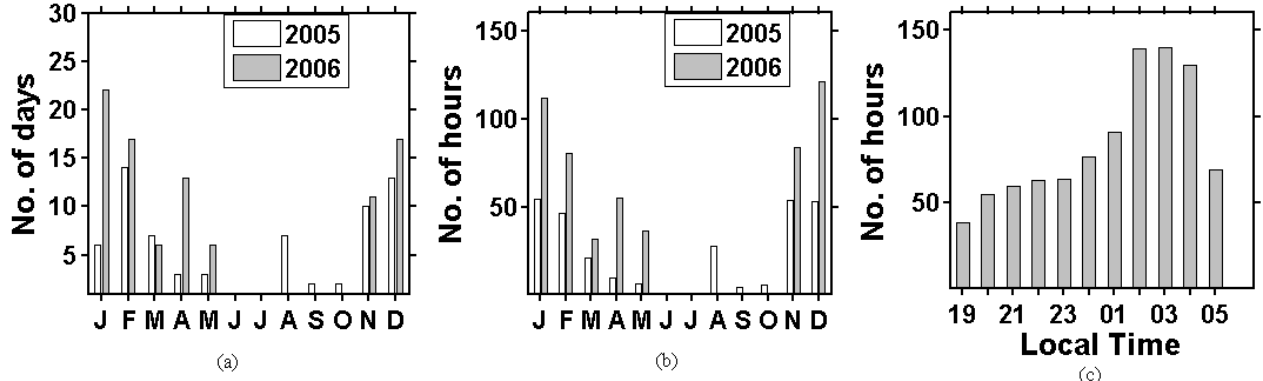
Fig. 1. Histograms showing monthly distribution of data for the period from January 2005 to December 2006 (a) number of days, (b) number of hours of sodium lidar data and (c) number of observational hours per local